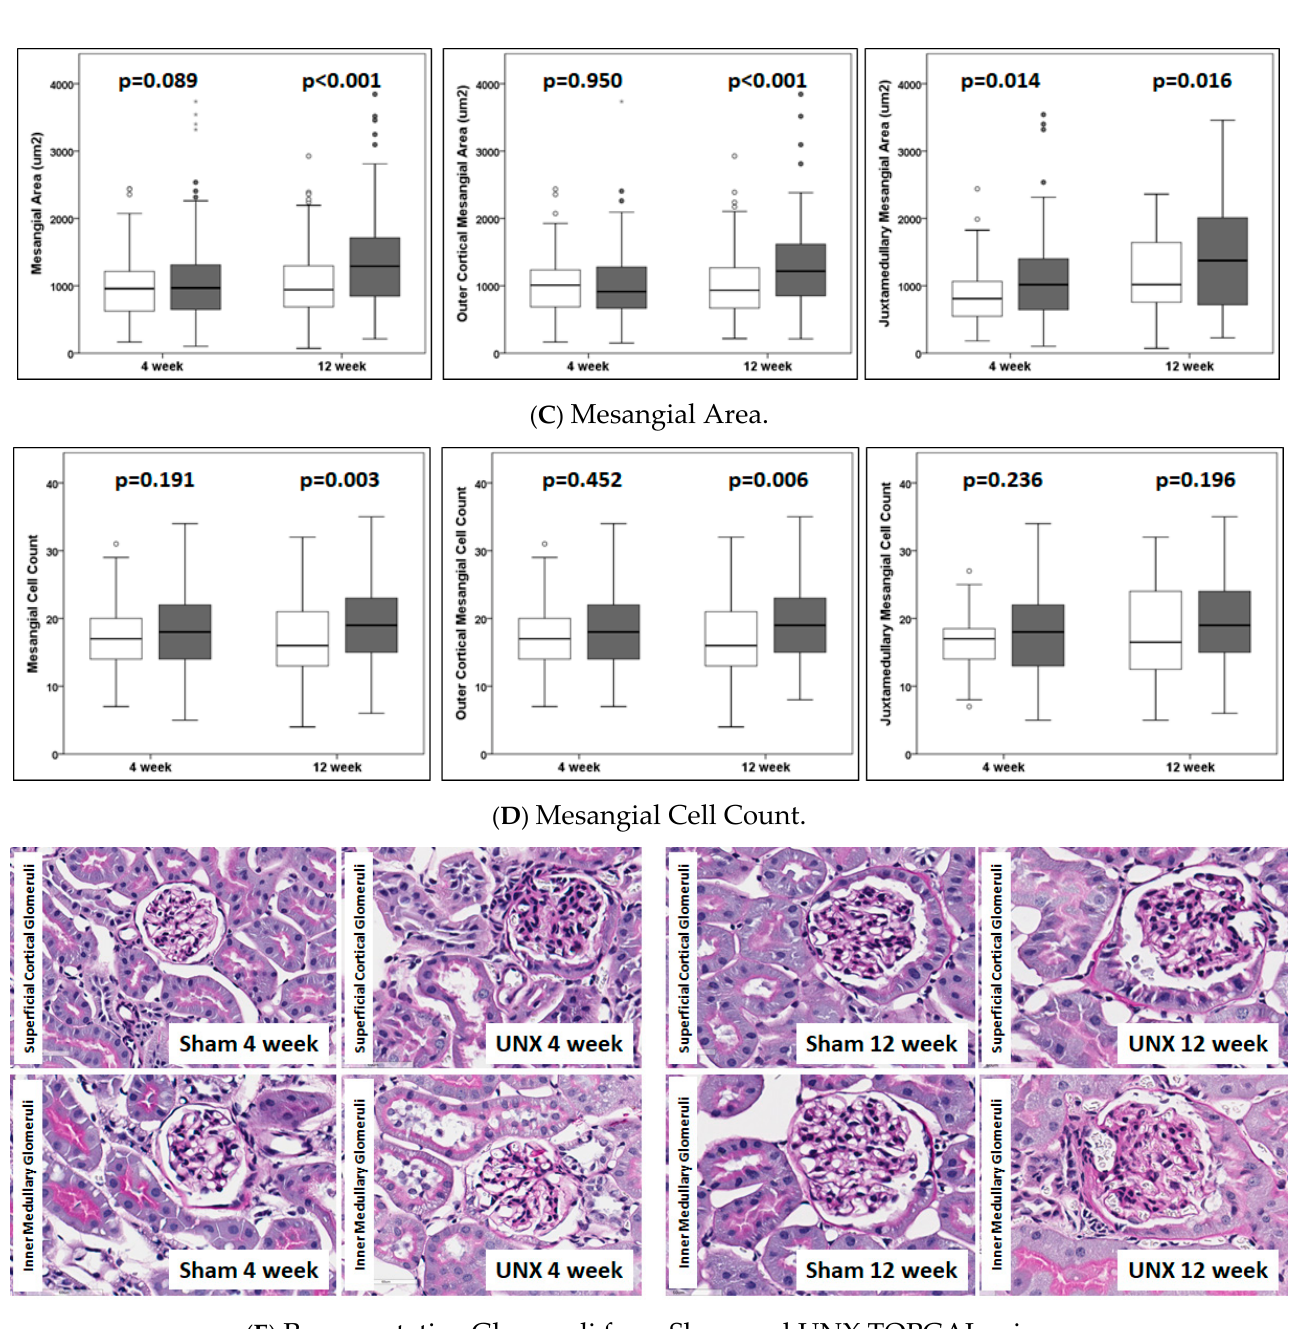
Figure 2. Box-plot distribution of ( A ) the glomerular area, ( B ) glomerular perimeter, ( C ) mesangial area, ( D ) mesangial cell count, and ( E ) representative glomeruli from superficial cortical glomeruli (upper row) and deep intramedullary glomeruli (lower row) in TOPGAL animals at 4 and 12 weeks following unilateral nephrectomy or sham treatment at 4 weeks of age. These measurements were performed on 15 glomeruli (10 outer cortical glomeruli and 5 inner juxtamedullary glomeruli) in kidneys stained with Periodic Acid-Schiff stain at 4 weeks and 12 weeks. The data from all glomeruli are shown in the left panel, outer cortical glomeruli in the middle panel, and inner juxtamedullary glomeruli in the right panel. There were 12 sham and 12 UNX animals at 4 weeks and 11 sham and 12 UNX animals at 12 weeks. The values represent the mean ± SD; the p -values were obtained using unpaired Students’ t -test. The circles in box-plot distribution represent outliers.